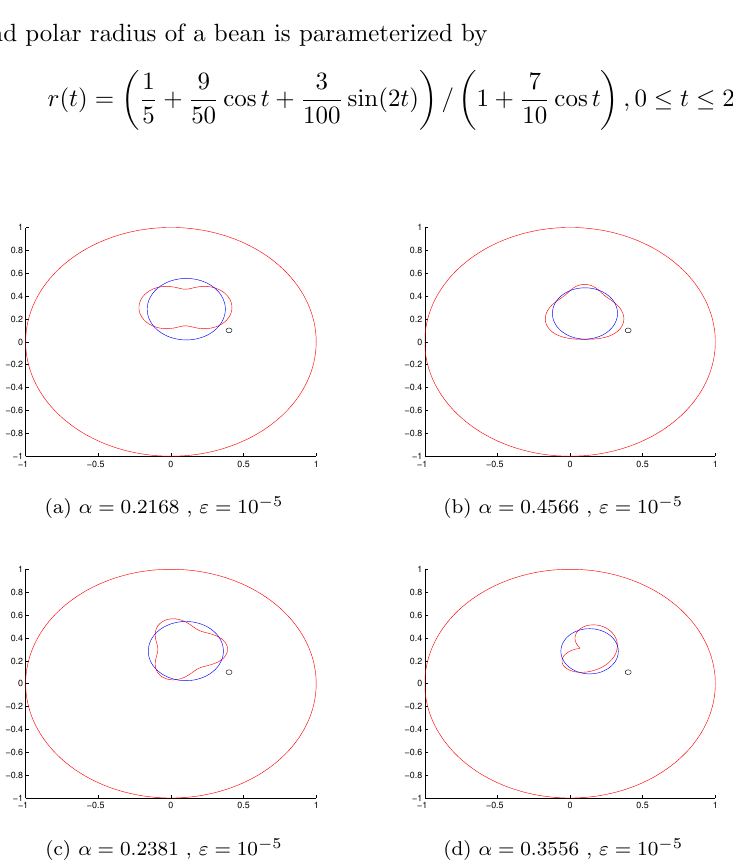
Figure 3. (a) Peanut; (b) peach; (c) pear; (d) bean. Apply LMA to determine the location O and the size ρ of the coefficient along with exact solution (red), initial guess (black) and recovered solution (blue), respectively for Example